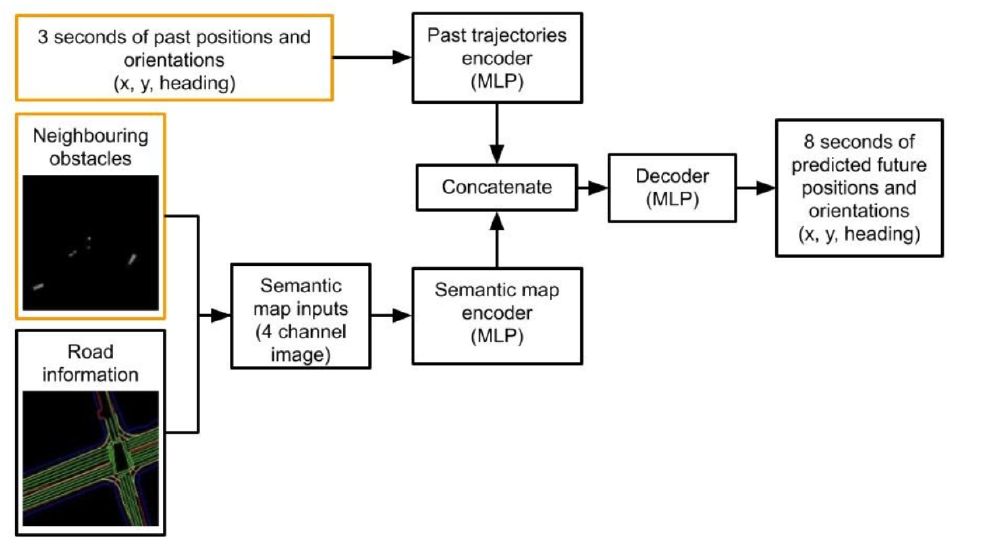
Figure 9. Autoencoder (AE) architecture of the prediction